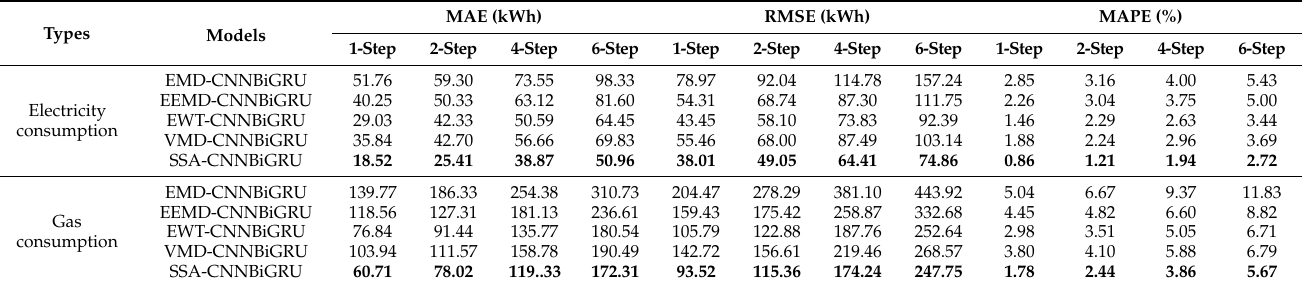
Table 7. Comparison of prediction error evaluation indexes based on the CNNBiGRU model with different decomposition